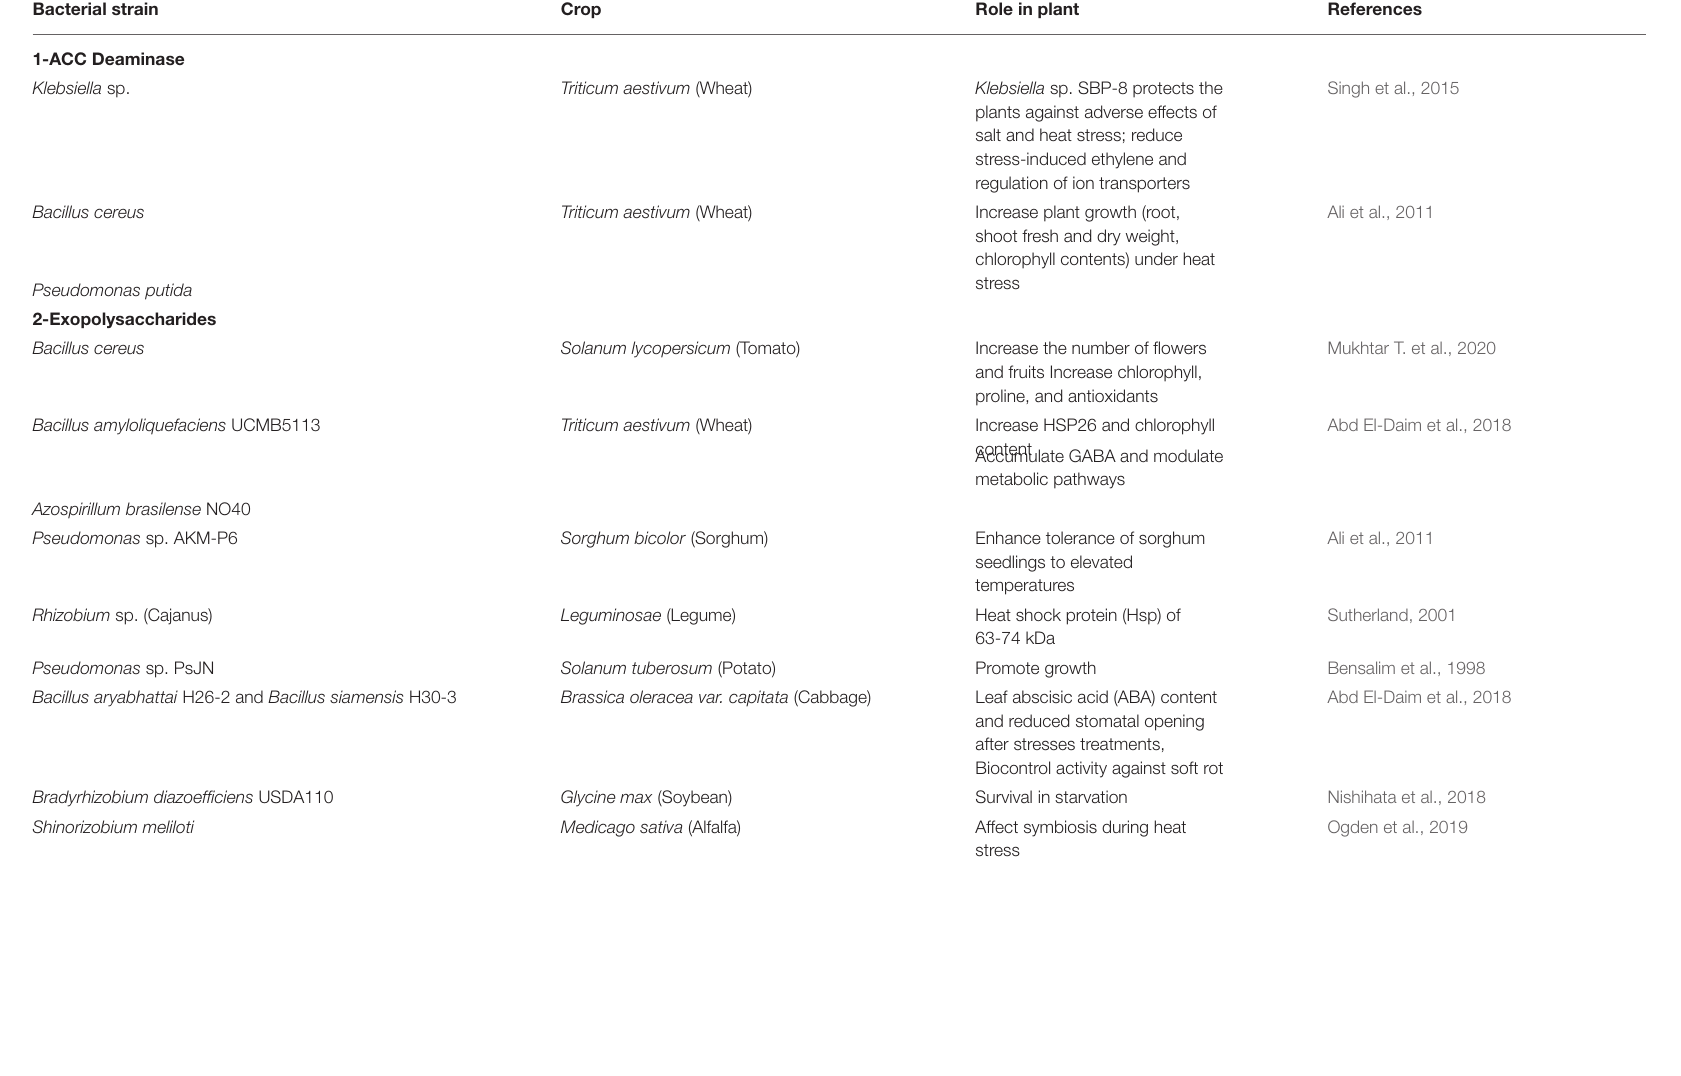
TABLE 4 | Role of PGPR in plant under stress